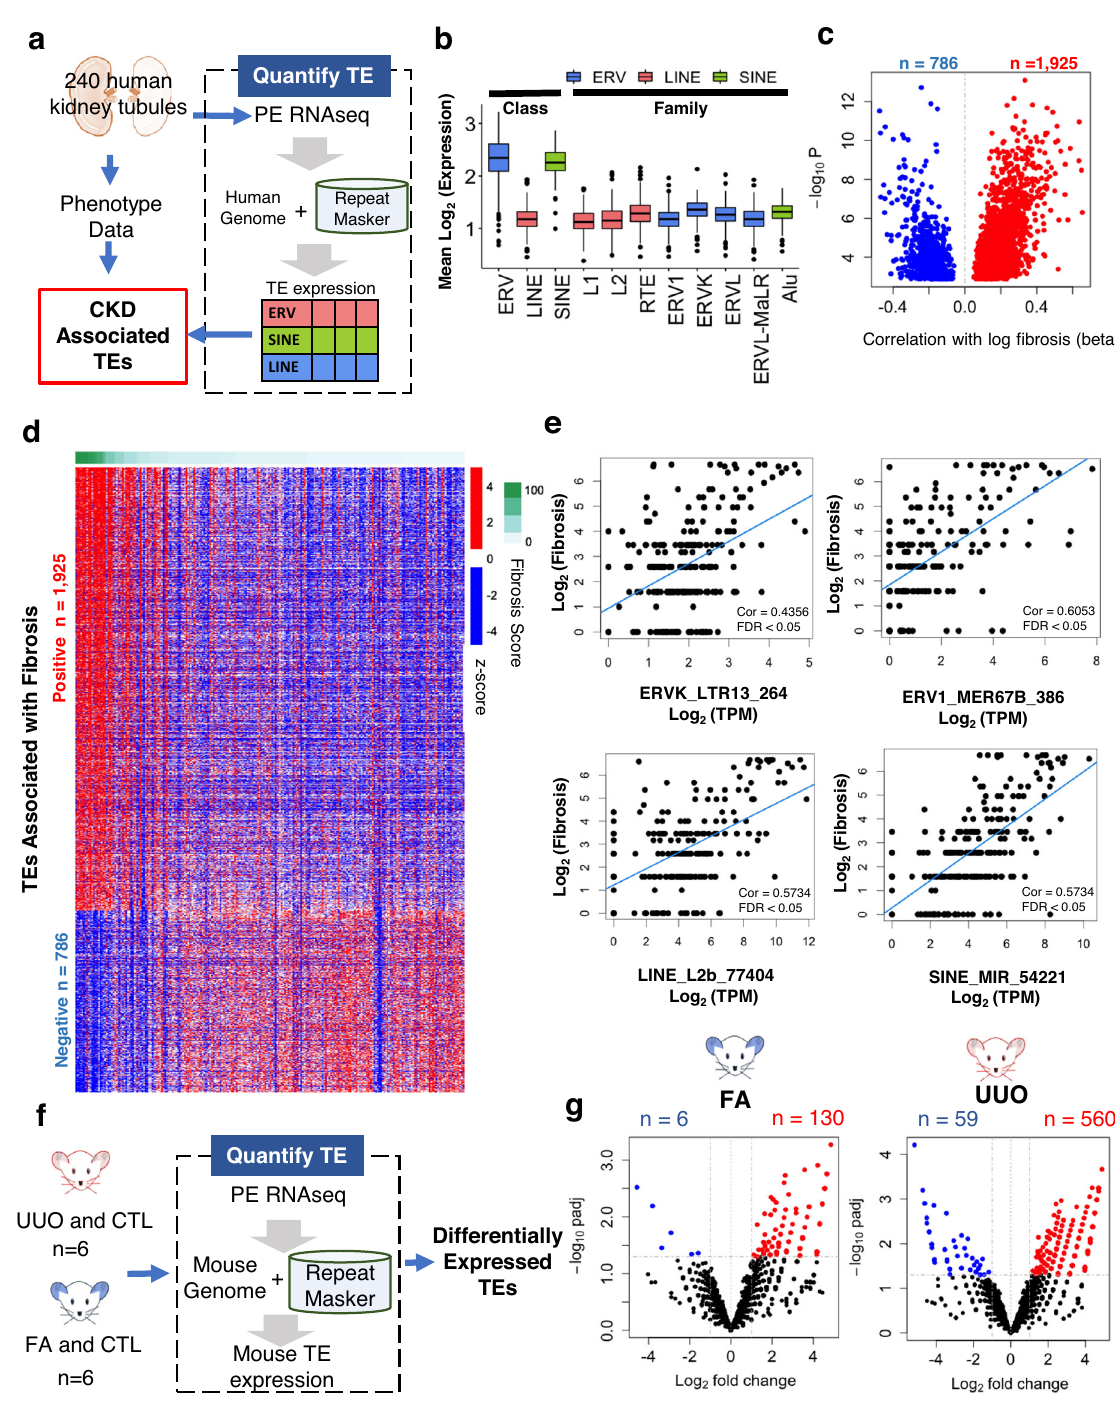
Fig. 1 | Kidneyexpressionoftransposableelements(TEs) and theirassociation with kidneydisease severity inpatientsand mice.a Our bioinformatic approach for TEdiscovery and quanti fi cation in 240 human kidney tubule samples. b Boxplot representing the relative (Mean log 2 TPM) expression of TE classes, endogenous retrovirus (ERV, blue), long interspersed nuclear elements (LINE, red), and short interspersed nuclear elements (SINE, green) and their families (ERV1, ERVK, ERVL, ERVL-MaLR, Alu, L1, L2, and RTE i.e., other retrotransposons). Center lines show the medians; box limits indicate the 25th and 75th percentiles; the bottom whisker indicates the fi fth percentile and the top whiskers indicate the 95th percentile ( n =240 biologically independent samples) . c Volcano plot of TEs showing associa- tionwithkidney fi brosisinhumankidneysamples.TheX-axisshowsthebetavalues in the linear regression model (adjusted) for fi brosis. Y-axis shows the statistical signi fi cance(negativelog p value).ReddotsshowhigherTEsandbluedotslowerTEs